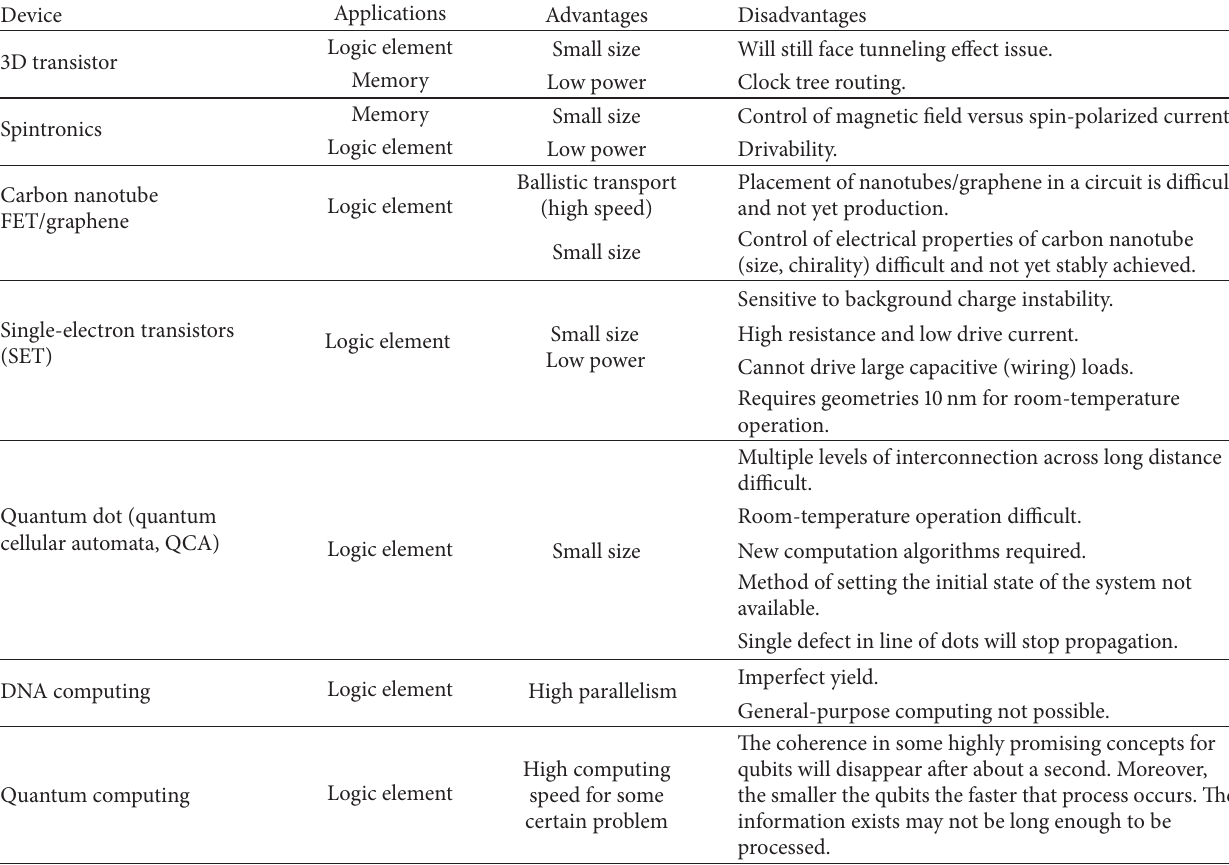
Table 2: Key future